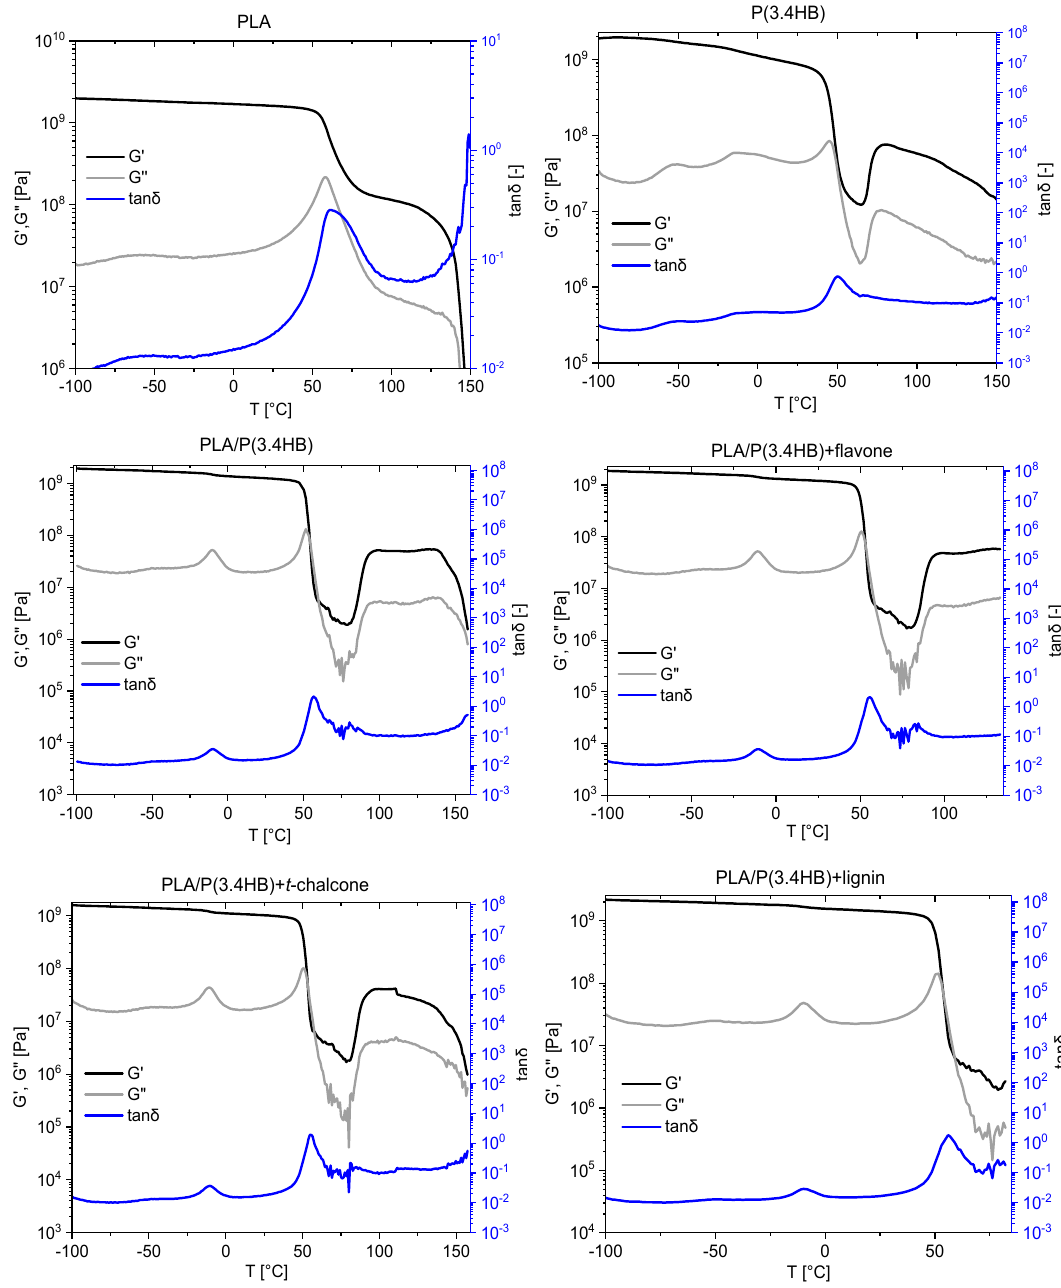
Figure 4. The temperature-dependent functions of storage modulus G (cid:48) (Pa), loss modulus G” [Pa] and the loss factor tan δ for PLA, P(3.4 HB) as well as blends with natural